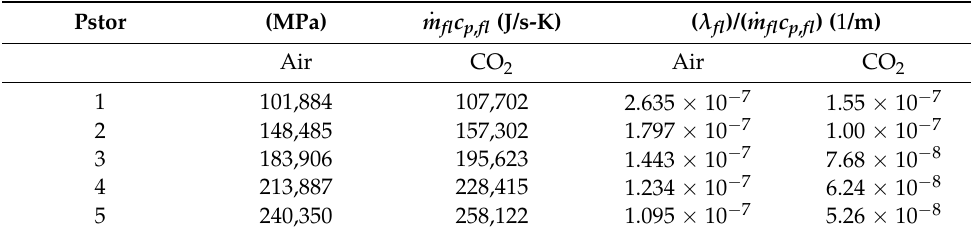
Table 2. Heat capacity and exponential power of CO 2 and air for Equations (10) and (11) (cooling device at 0.1 MPa).